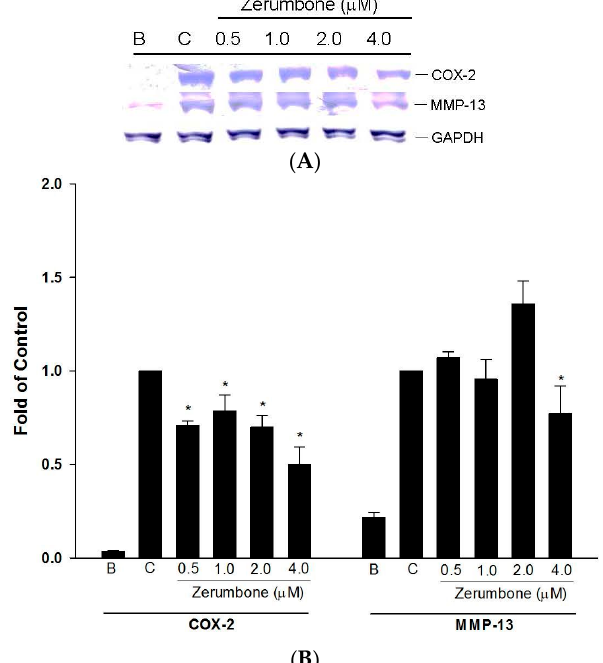
Figure 2. ( A ) Effects of zerumbone inhibiting matrix metalloproteinase (MMP)-13 expressions on interleukin (IL)- β -induced chondrocytes; ( B ) Quantitational and statistical analysis of protein expressions, * p < 0.05 compared to control; Data were used from three separate experiments; a picture of one is shown. C: control, cells were pretreated with vehicle and IL-1 β (10 ng/mL) B: blank.